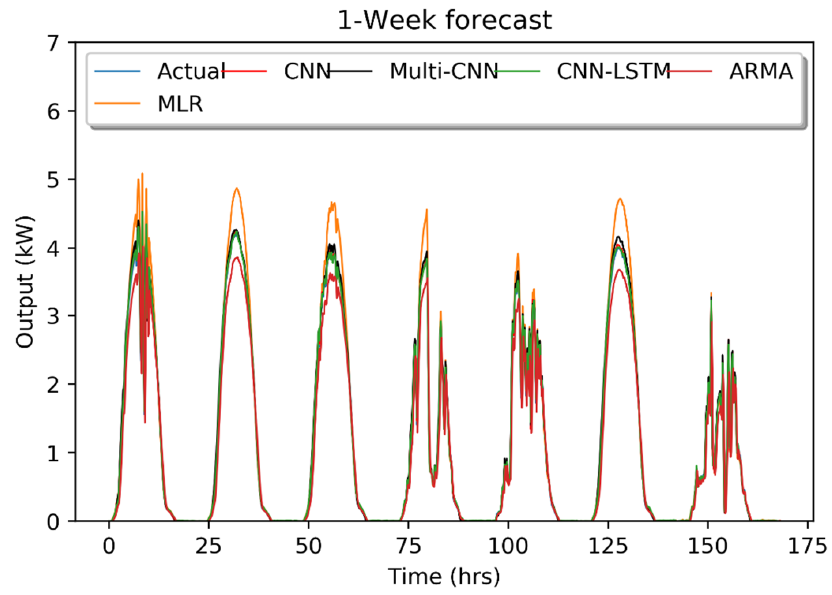
Figure 9. Comparison of di ff erent methods for the 1-week forecast